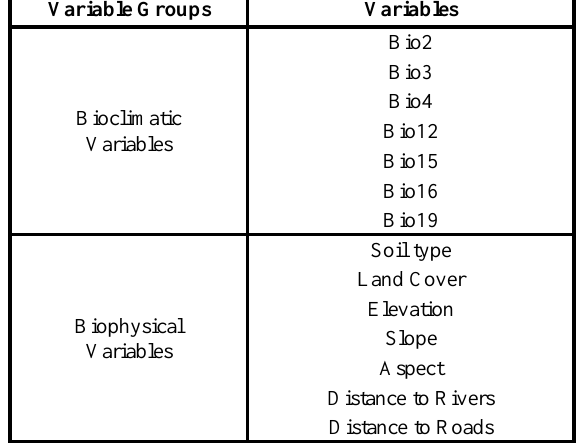
Table 1. Variables used in the Final